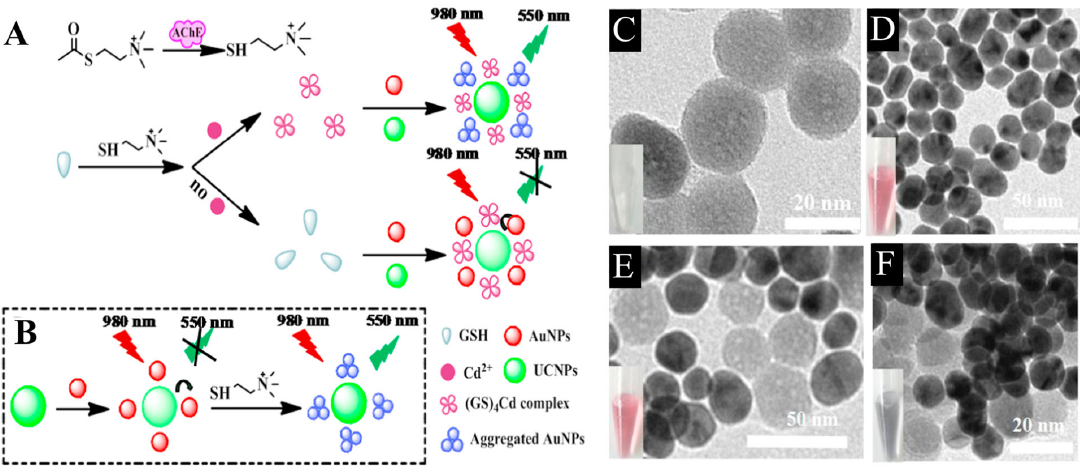
Figure 3. Sensing principle of the bifunctional UCNPs/AuNPs based nanoprobe for detection of ( A ) AchE and ( B ) Cd 2+ ions with GSH regulation. Representative TEM images of ( C ) UCNPs, ( D ) AuNPs, ( E ) UCNPs/AuNPs, and ( F ) aggregation in UCNPs/AuNPs caused by post-addition of AChE and ATC. Reprinted with permission from reference [62].